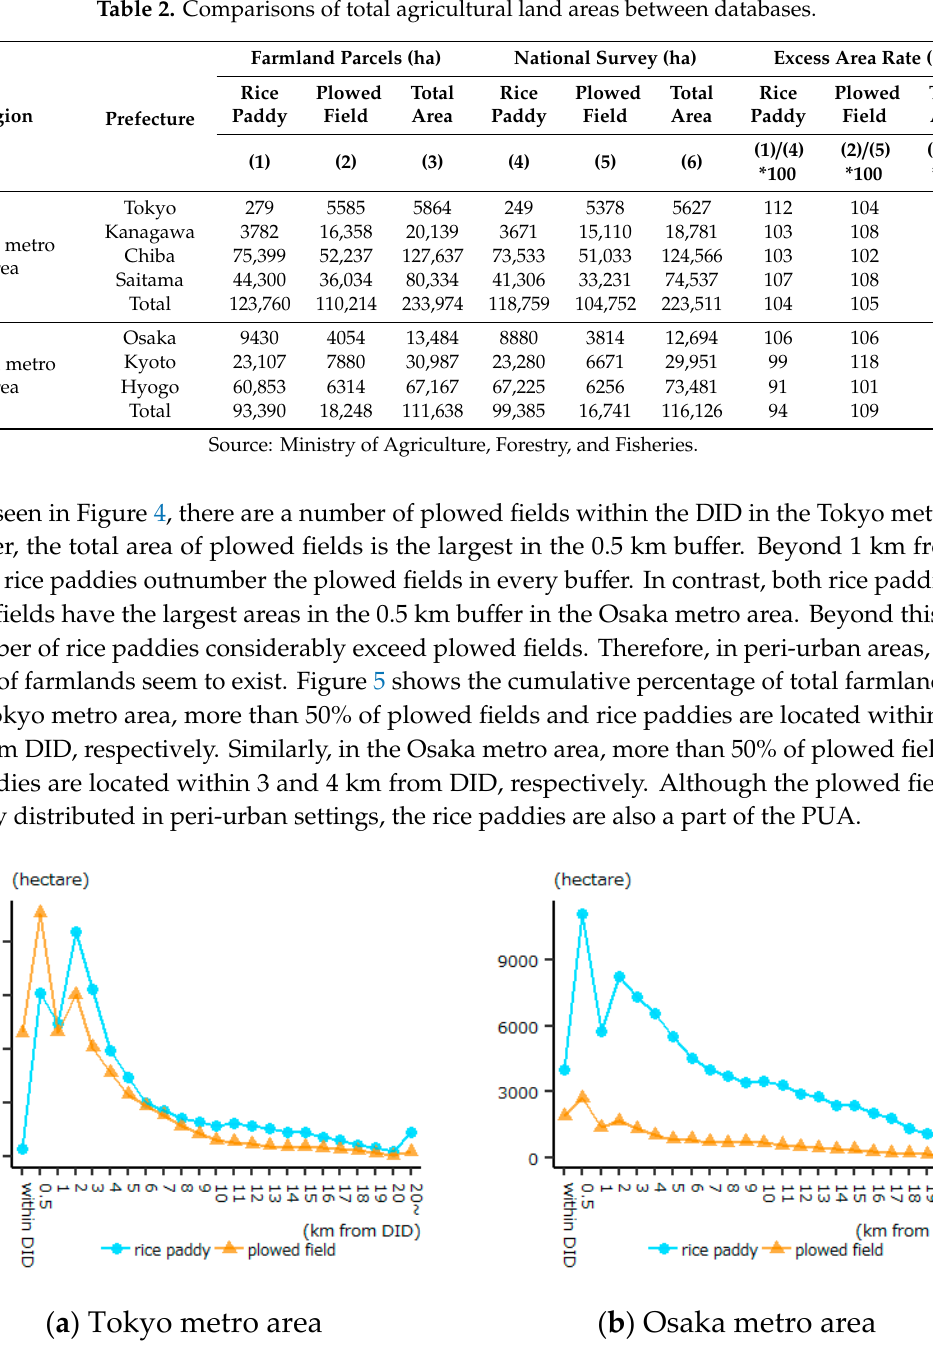
Figure 4. Total areas by distance from DID. ( a ) shows the case of Tokyo metro area and ( b ) shows the case of Osaka metro area.